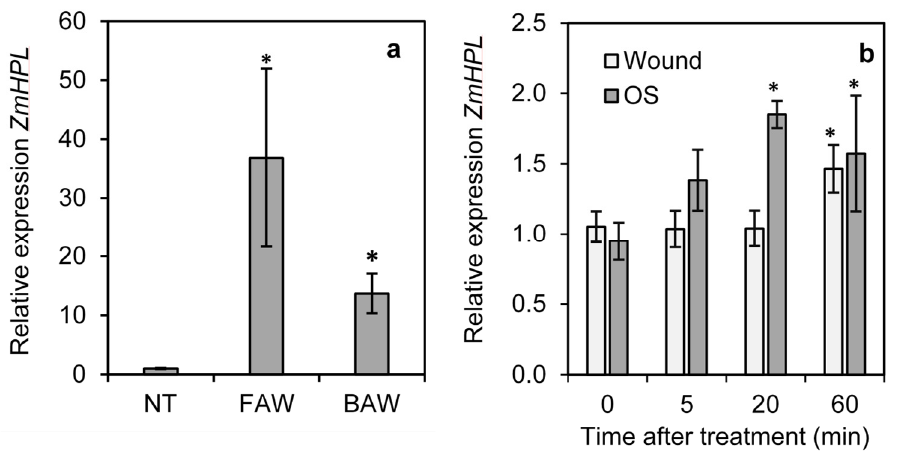
Figure 4. Impact of wounding and S. frugiperda or S. exigua feeding on the expression of ZmHPL . The relative expression levels of ZmHPL were determined in wild-type maize plants infested with S. frugiperda neonates (FAW) or S. exigua neonates (BAW) for 24 h or not treated (NT) ( a ); or in maize plants wounded with a razorblade or wounded and treated with S. frugiperda oral secretions (OS) ( b ). Bars show the average of n = 4 samples per line, ± S.E.M. Asterisks indicate relative expression significantly different from NT or 0 time at p ≤ 0.05 by t -test.